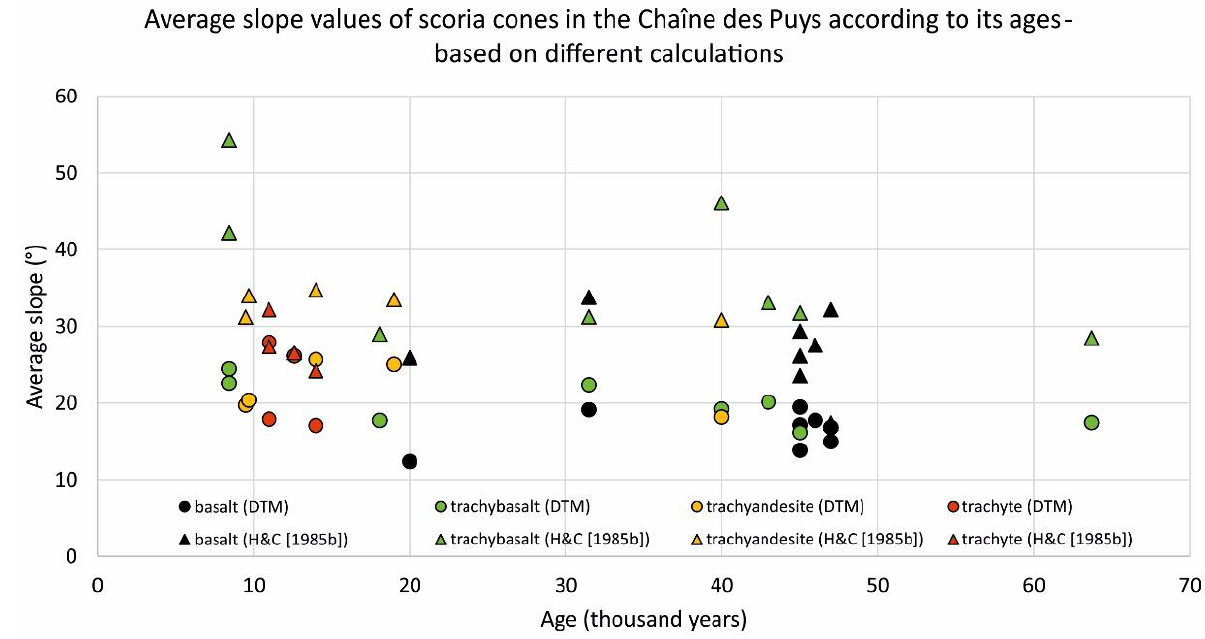
Figure 16. Summary of slope values based on H&C equations [35] (dots) and DTMs (triangles) according to its ages. Coloring is based on lithology (black: basalt, green: trachybasalt, yellow: trachyandesite, red: trachyte).